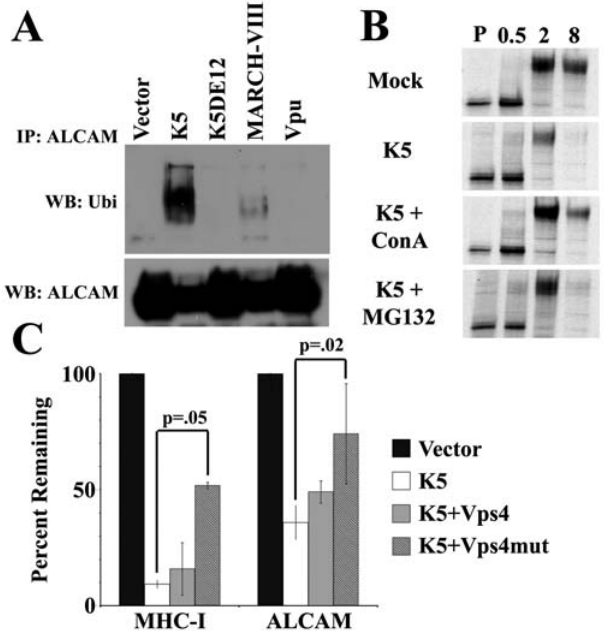
Figure 6. Ubiquitination and Lysosomal Degradation of ALCAM in the Presence of K5 (A) Ubiquitination of ALCAM was examined by co-transfection of HeLa cells with ALCAM-HA as well as the indicated E3 enzymes. Then 24 h post-transfection, cells were lysed in 1% CHAPS, and ALCAM-HA was immunoprecipitated using anti-HA antibody. Samples were resolved on an 8% SDS-PAGE gel, transferred to PVDF, and immunoblotted (WB) with the anti-ubiquitin (Ubi) antibody P4D1 (top) or anti-HA (bottom). Ubiquitinated ALCAM was visible upon co-transfection of K5 and MARCH-VIII, but not with the inactive K5DE12 mutant and the unrelated HIV immune modulator vpu. (B) To determine whether ubiquitinated ALCAM was degraded by proteasomes or in lysosomes, the fate of newly synthesized ALCAM-HA was determined by metabolic labeling for 10 min with S 35 Met/Cys and chasing the label for the indicated times (hours) in the presence of the indicated inhibitors. Following lysis, ALCAM-HA was immunoprecipitated using the HA antibody and samples were treated overnight with endoglycosidase H followed by electrophoretic separation. Note the increased recovery of ALCAM at 8 h in the presence of the endosomal/ lysosomal proton pump inhibitor concanamycin A (ConA), but not in the presence of the proteasomal inhibitor MG132 (50 l mol). (C) Surface expression of ALCAM can be restored by overexpressing a dominant negative version of the AAA-ATPase Vps4, which is essential for targeting proteins to MVBs. HeLa cells were transfected as indicated together with GFP to identify transfected cells. Then 24 h post- transfection, cells were harvested and the surface expression of either MHC I or ALCAM was analyzed using flow cytometry. The graph shows the ratio of mean fluorescence intensity from K5-transfected cells to that of control cells after gating for GFP. Data are averaged from three separate